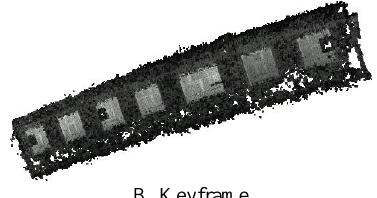
Figure 9. The output of the generation of the 3D thermal dense point cloud of the test dataset . Figure (9. A) Depicts the output of the thermal infrared 3D figure (9. B) Illustrates the output of the 3D dense point